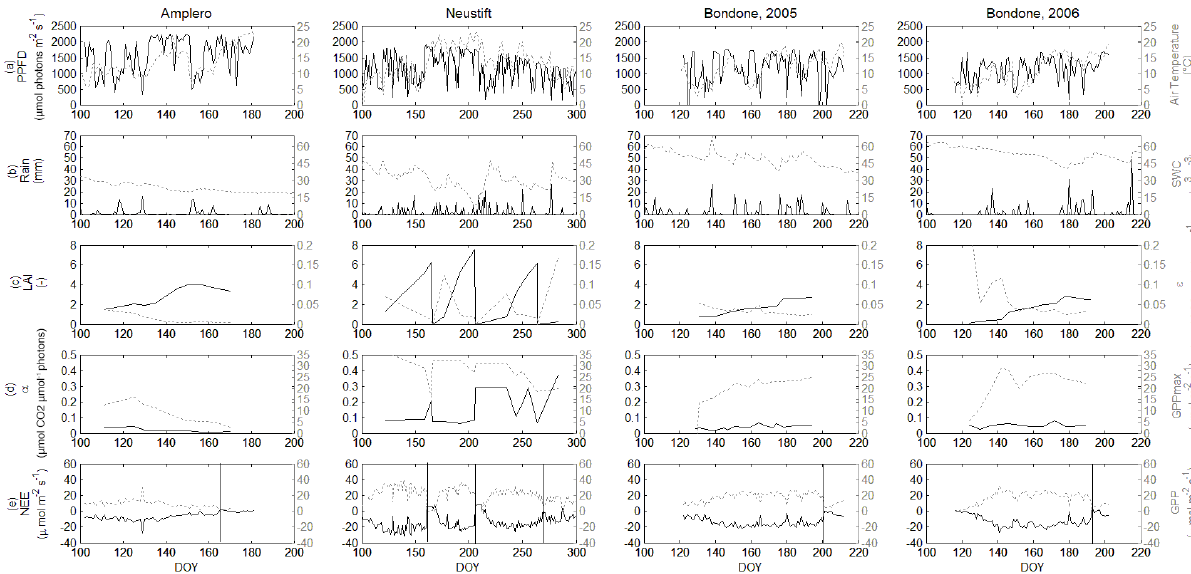
Figure 2. Seasonal variation of meteorological variables, LAI, CO 2 fluxes and ecophysiological parameters for the period of the hyperspectral measurements at the three investigated grasslands. (a) Midday average photosynthetically active radiation (PAR;µmolm − 2 s − 1 ; solid black line) and daily average air temperature ( ◦ C; dotted grey line); (b) daily precipitation (Rain; mm; solid black line) and daily average soil water content (SWC; m 3 m − 3 ; dotted grey line); (c) leaf area index (LAI; m 2 m − 2 ; solid black line) and light use efficiency ( ε ; µmol photons µmol − 1 CO 2 ; dotted grey line); (d) apparent quantum yield ( α ;µmol CO 2 µmol − 1 photons; solid black line) and gross primary production at saturating light (GPP max ; µmolm − 2 s − 1 ; dotted grey line); (e) midday average net ecosystem CO 2 exchange (NEE; µmolm − 2 s − 1 ; solid black line) and gross primary production (GPP; µmolm − 2 s − 1 ; grey dotted line); vertical lines in the lowermost panels indicate the dates of mowing.